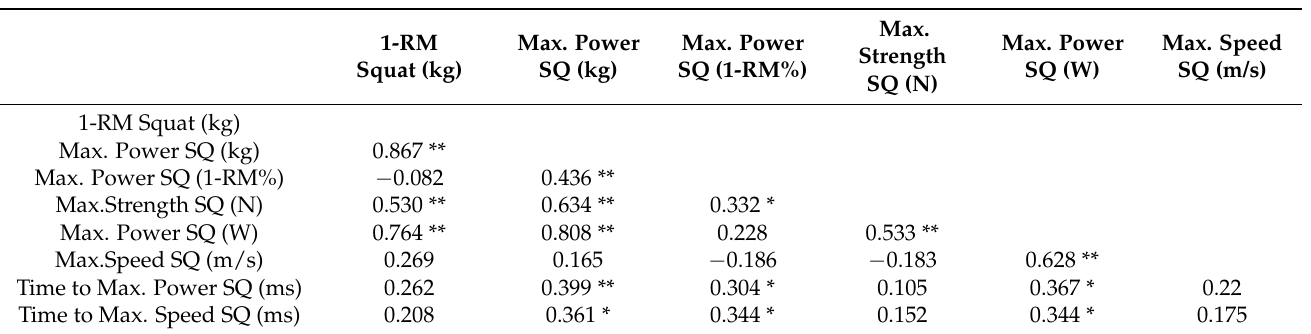
Table 4. Correlation among squat variables.